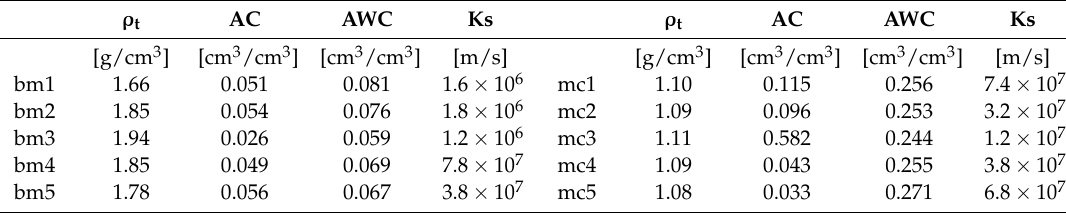
Table 3. Soil physical properties of the investigated boulder marl (bm1–bm5) and marsh clay (mc1–mc5) considering the dry bulk density ( ρ t ), air capacity (AC), the plant available water capacity (AWC), and saturated hydraulic conductivity (Ks) with 10 to 15 soil cores per Proctor stage. The symbol ± indicates the standard deviation.